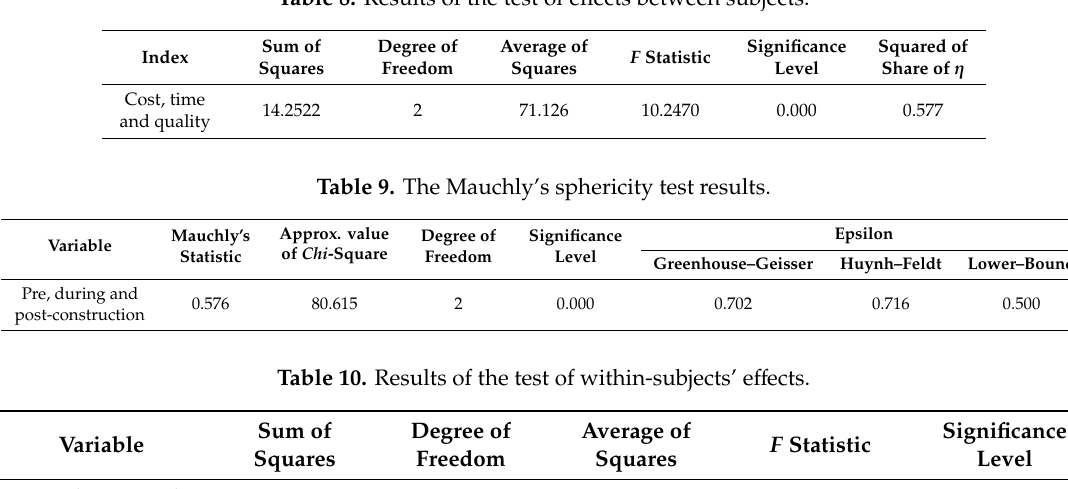
Table 8. Results of the test of e ff ects between subjects.